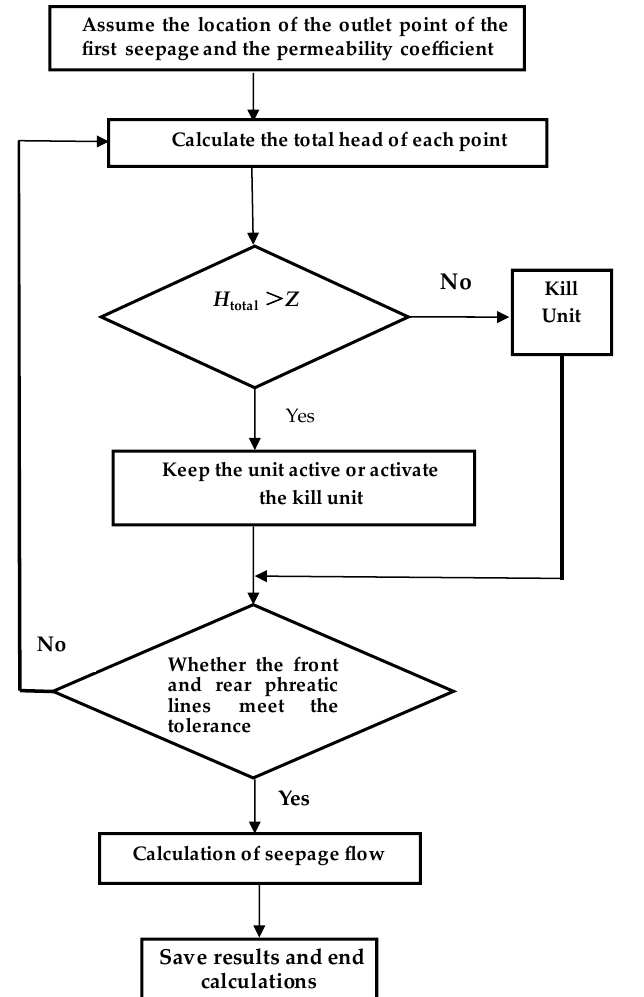
Figure 1. Proposed calculation model for Seepage.